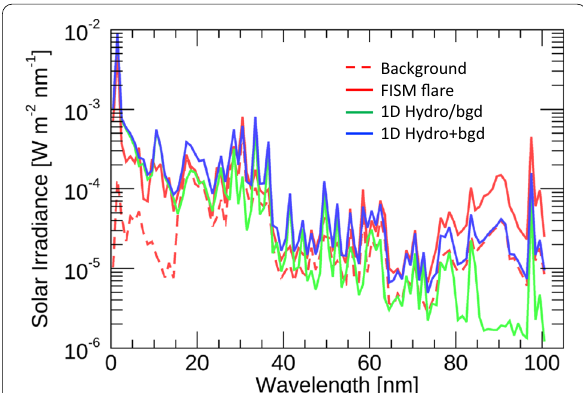
Fig. 2 Emission spectra of X9.3 flare at 12 UT. The red solid line shows the FISM spectrum and the green solid line shows the 1D Hydro flare model spectrum. The blue solid line is the sum of the 1D Hydro flare model spectrum (green solid line) and the background (red dashed line). Because the 1D Hydro flare model does not consider the continuum component, there is no continuum component around 70–90 nm